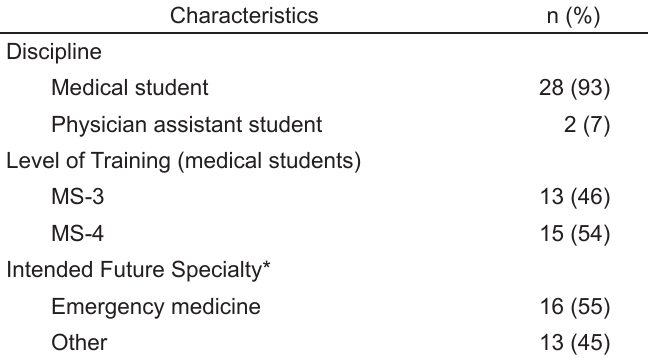
Table 1. System Usability Scale questionnaire participants.